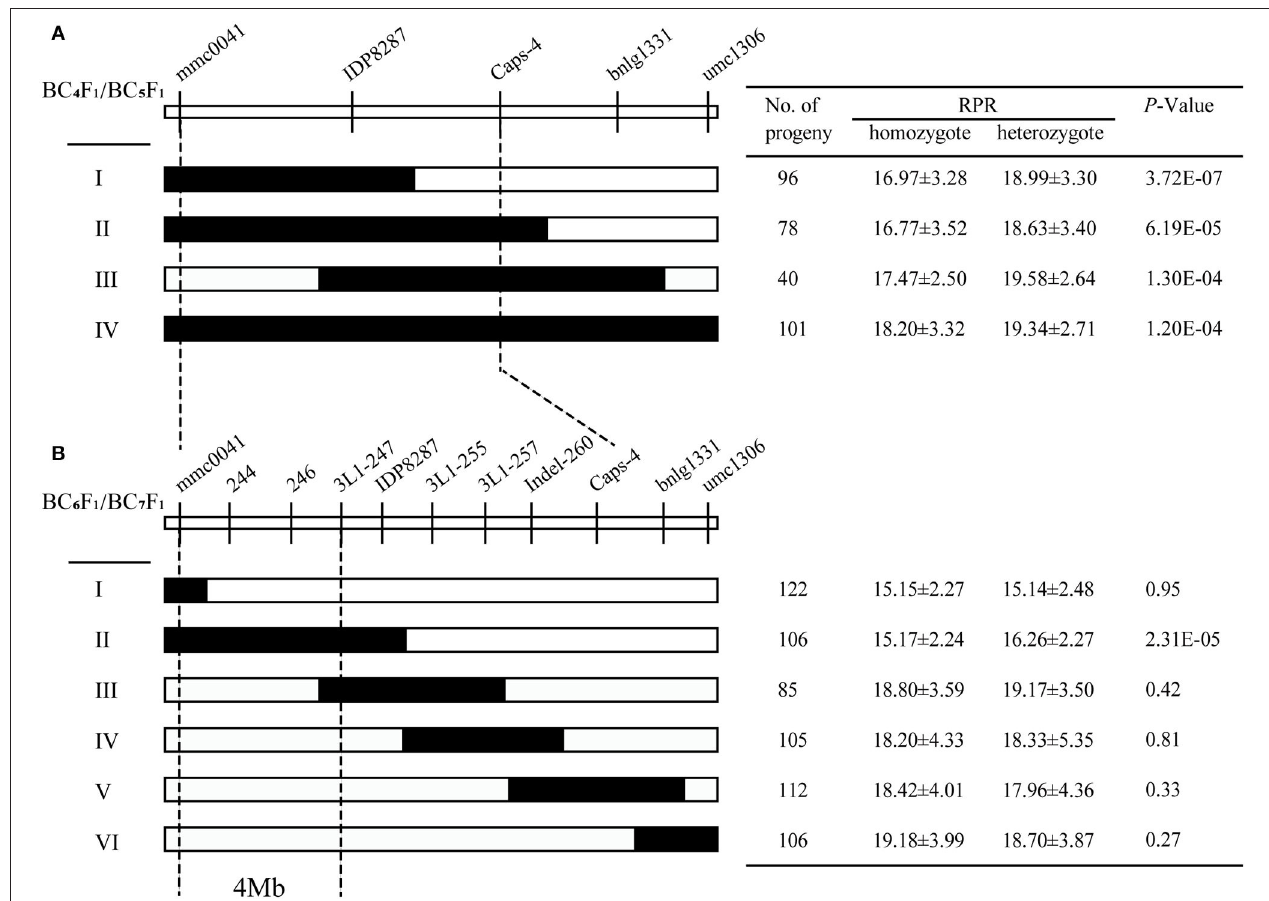
FIGURE 4 | Fine mapping of qRPR1-3 . Seven BC 4 F 1 (A) and 19 BC 6 F 1 (B) recombinants of qRPR1-3 was classified into four and six types, respectively. In each recombinant type, the chromosomal composition of qRPR1-3 is depicted as black or white, corresponding to heterozygous 3705I/LH277 and homozygous 3705I/3705I, respectively. The black-dotted lines indicate the narrowed regions of qRPR1-3 . A significant difference ( p < 0.05) between heterozygote 3705I/LH277 and homozygote 3705I/3705I indicated the presence of qRPR1-3 in the donor region. The location of qRPR1-3 was refined from a 26.8Mb region to a 4Mb region flanked by the markers mmc0041 and